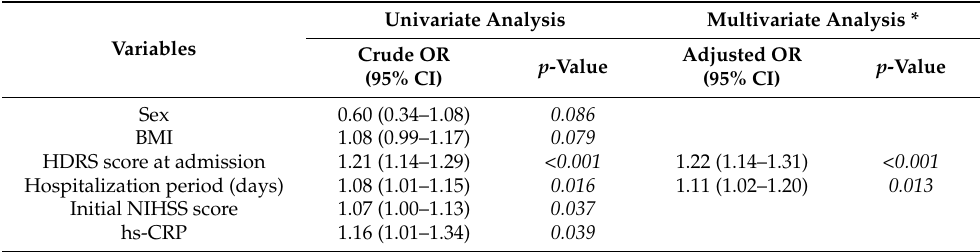
Table 2. Logistic Regression Analysis of Post-Stroke Depression After Three Months.